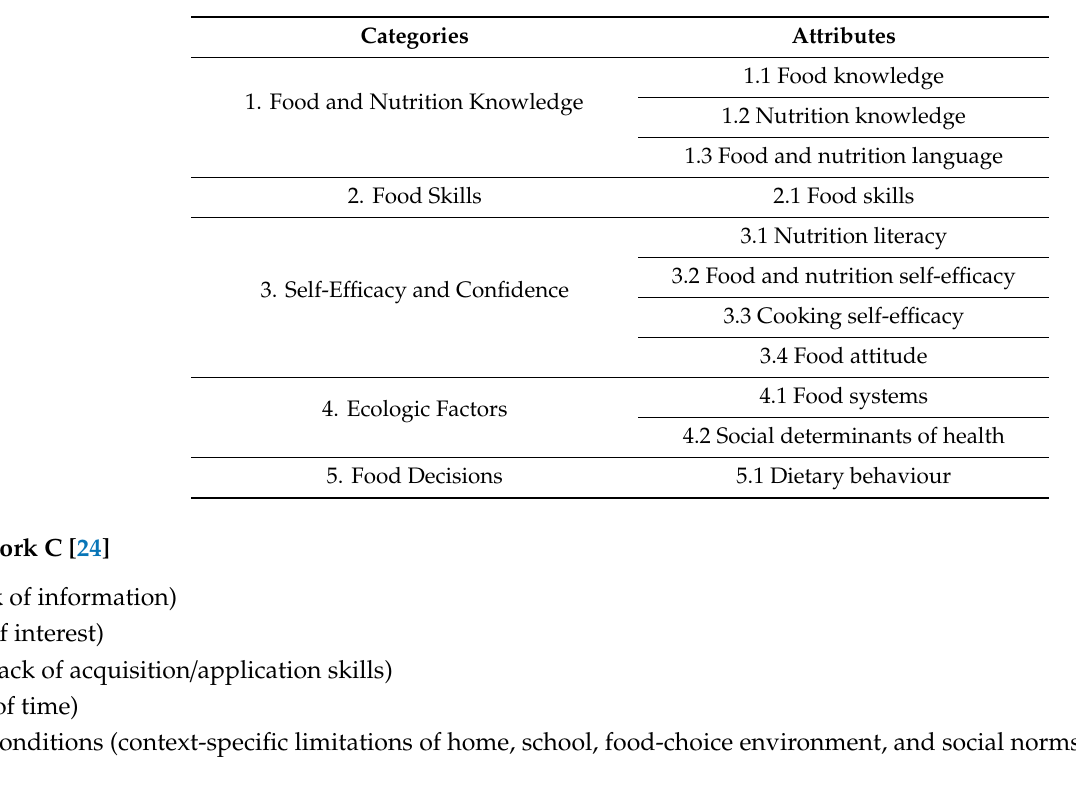
Table A2. Framework B